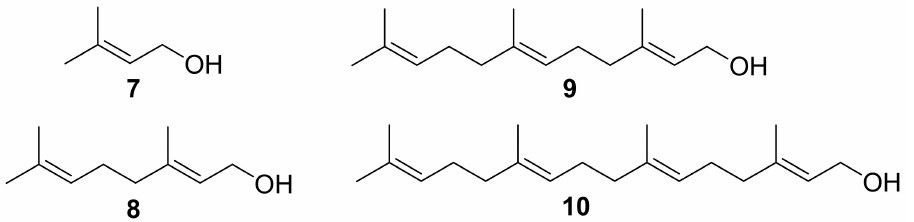
Figure 3. The prenyl alcohols 7 – 10 used in the synthesis of the analogs. Table 1. In vitro anthelmintic activity of compounds 1 – 10 at 500 µ g/mL in % mortality. Natural